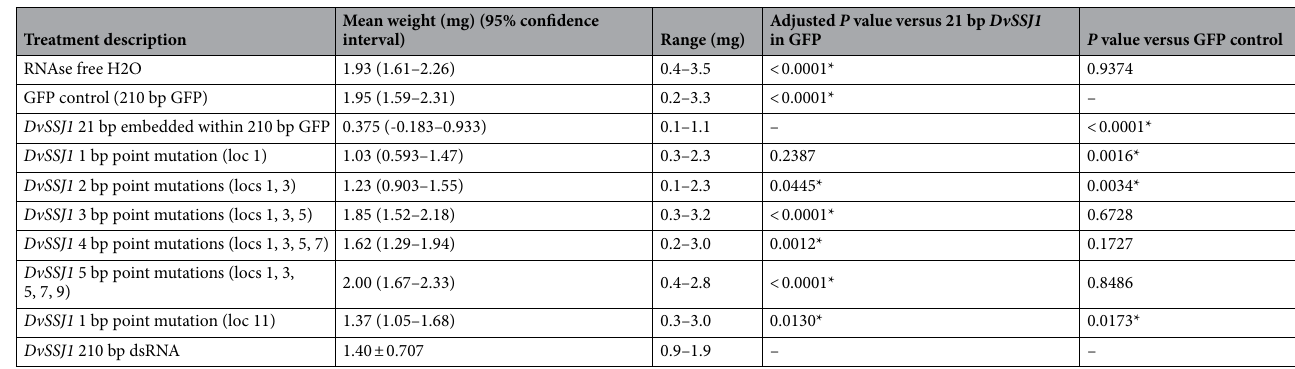
Table 4. Summary analysis of WCR weight results for dsRNA specificity data. Increasing single nucleotide polymorphisms (SNPs) were introduced in various locations (loc) within the DvSSJ1 21-mer and fed to WCR over 14 days to assess WCR weight. *A statistically significant difference ( P value < 0.05) was